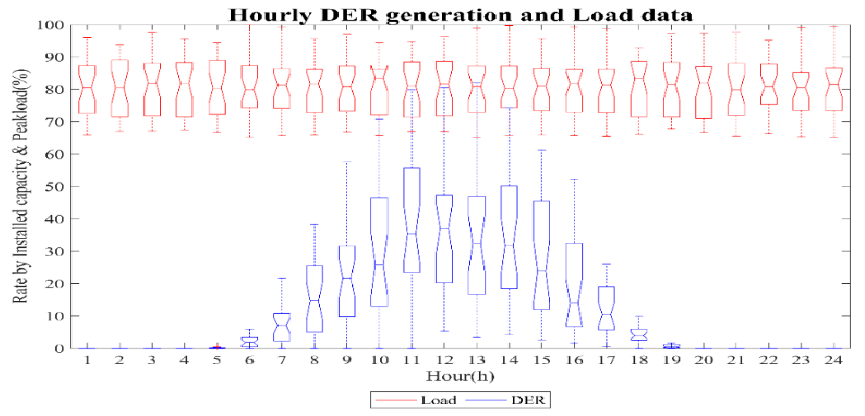
Figure 12. The hourly load and DER profile during July 2017.